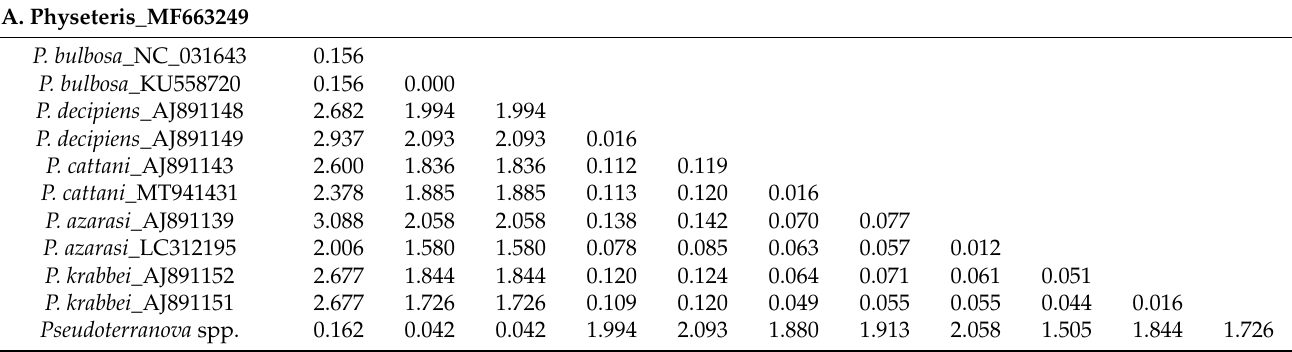
phylogenetic inference, indicating number of base substitutions per